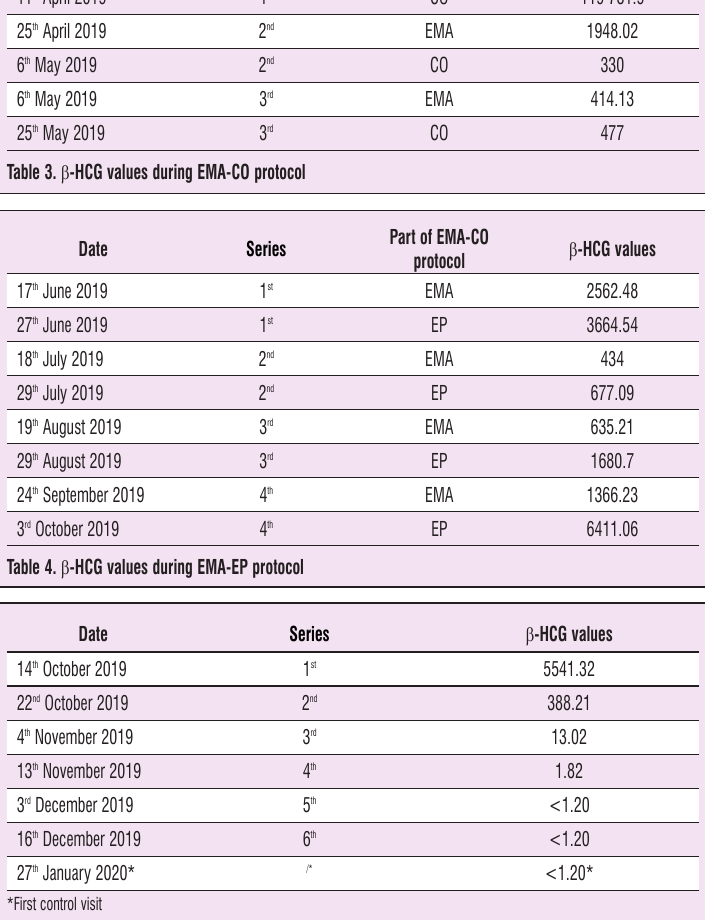
Table 5. β -HCG values during weekly EP